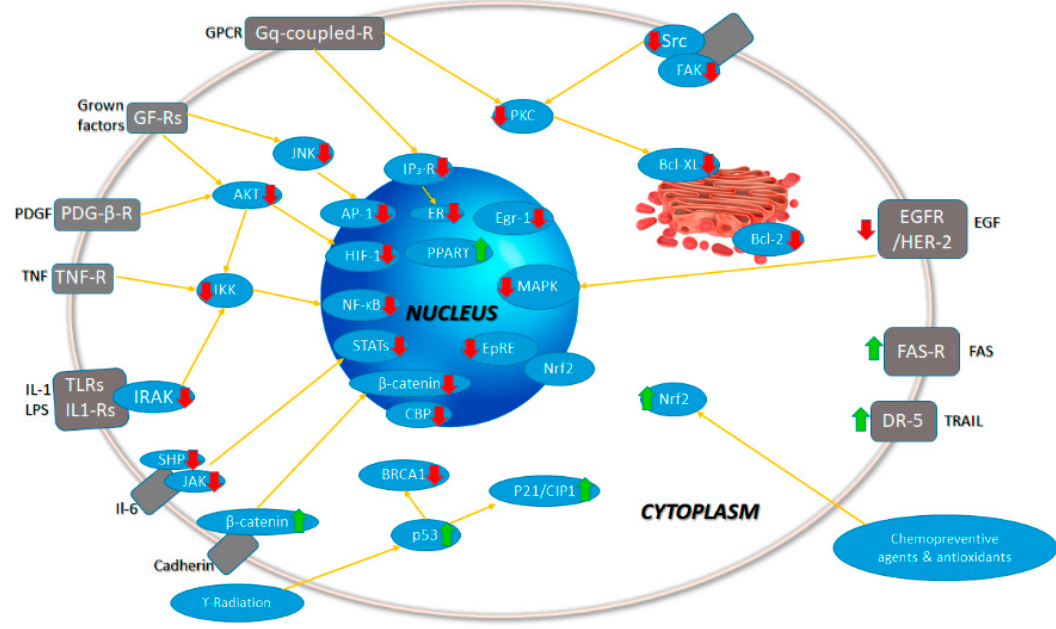
Figure 8. Signaling pathways modulated by curcumin. Up and green arrows indicate the intermediaries upregulated by curcumin; meanwhile, down and red arrows indicate the intermediaries downregulated by curcumin. Adapted with permission from [26]. 2007, Springer Nature.